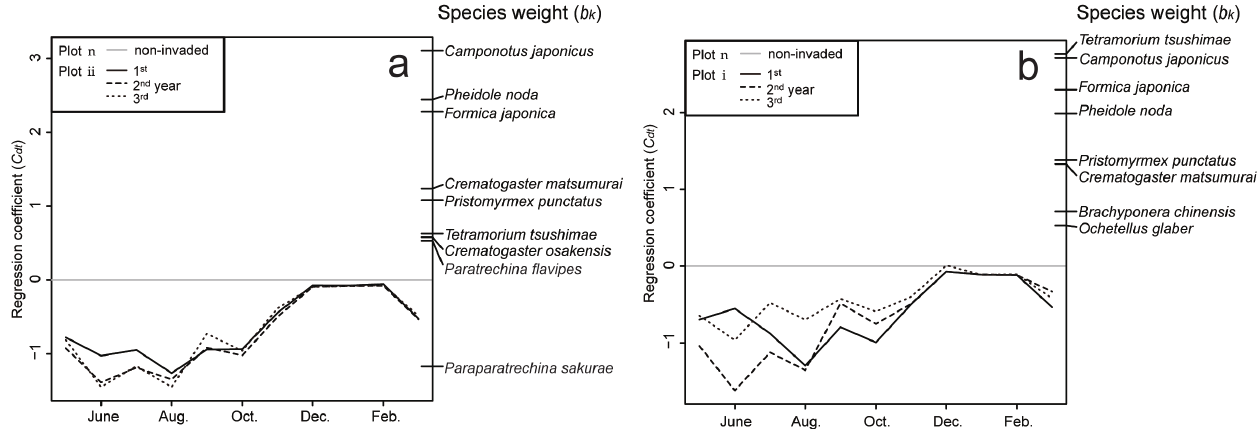
Fig 4. Principal response curve diagrams illustrating the shift of non-target ant communities over 3 years. (a) Plot ii, where no pesticide was applied after October 2013, and (b) Plot i, where no pesticide was applied after May 2012, relative to the control (untreated and non-invaded) plot over time. Left axis, regression coefficient; right axis, species weights (only species with a score of >0.5 or <−0.5 are shown). The first canonical axis explains 56.63% ( p < 0.001) of the total variation in Plot ii and 50.96% ( p < 0.001) in Plot